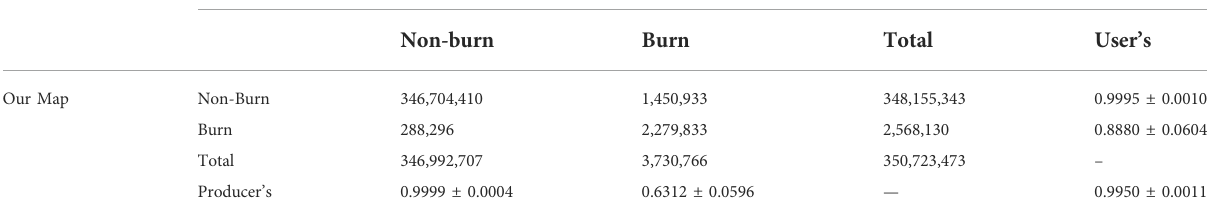
TABLE 3 Error matrix of population pixel count estimates and unbiased accuracies (with 95% con fi dence interval) of our map based on Stehman,